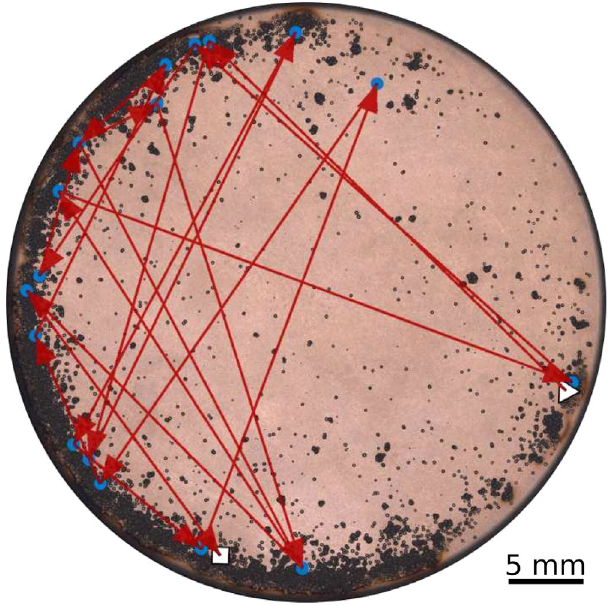
FIG. 13. Optical microscope image of the full surface of the hard Cu CERN cathode. On the surface, a series of 19 consecutive BDs is shown, each in a separate site randomly distributed near the edge of the cathode. White triangle and square indicate the first and last BDs,